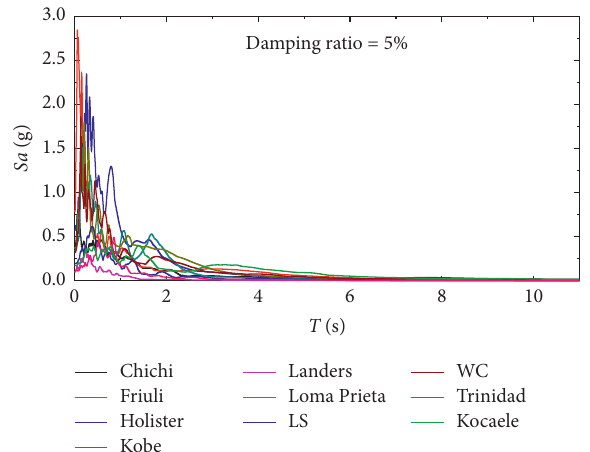
Figure 6: The acceleration response spectrum curves of 10 seismic